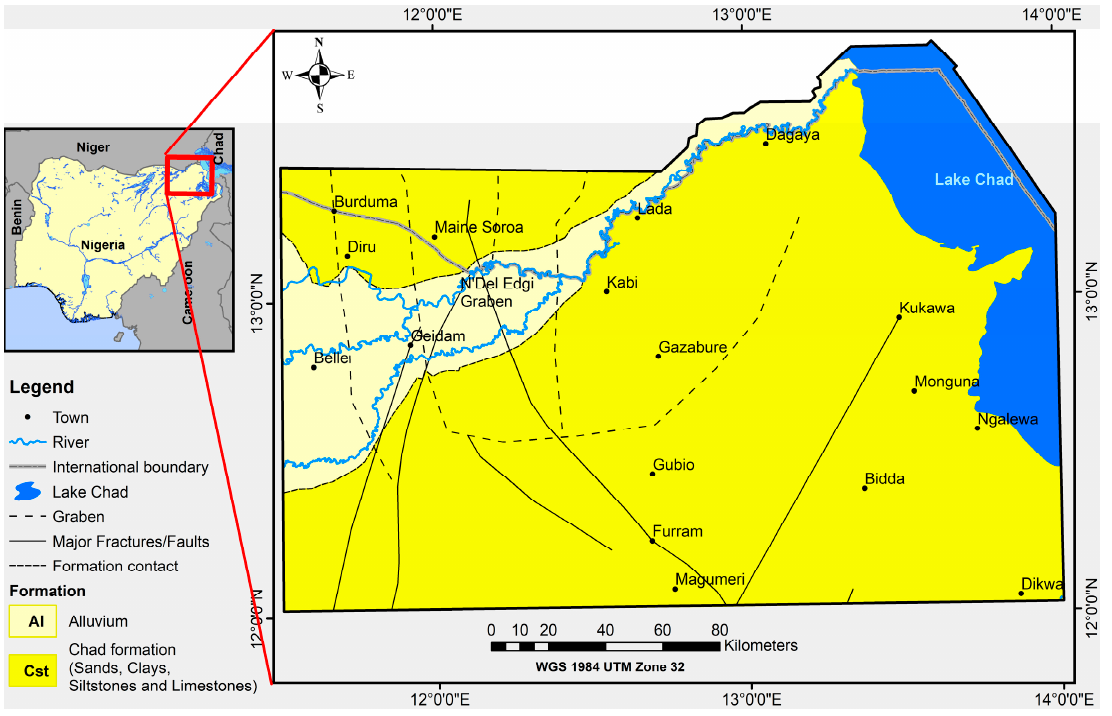
Figure 1. Geologic map of the study area.